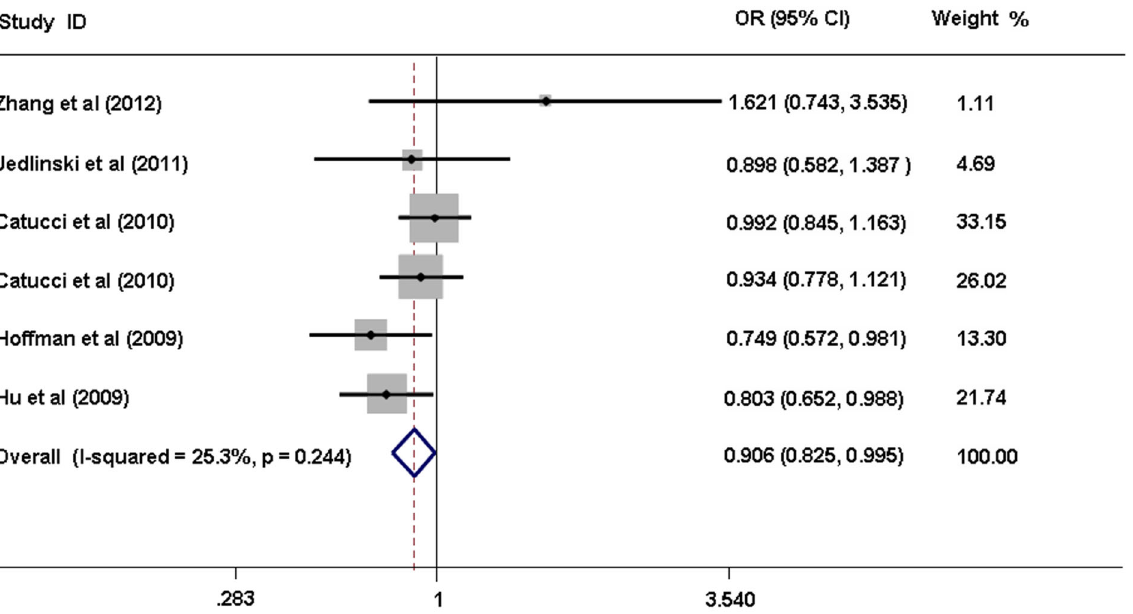
Figure 2. Forest plot for the association between miR-196a2 polymorphism and breast cancer risk. (Significant difference was observed for the comparison of miR-196a2 polymorphism (TT + CT) vs. CC using a fixed-effects model. OR, odds ratio; CI, confidence